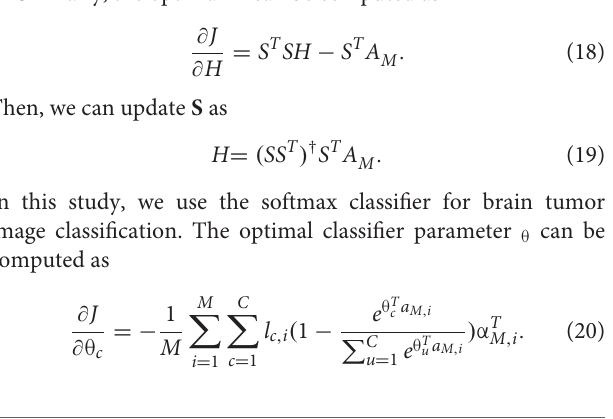
TABLE 3 | Confusion matrix of CDLLC on the REMBRANDT dataset.